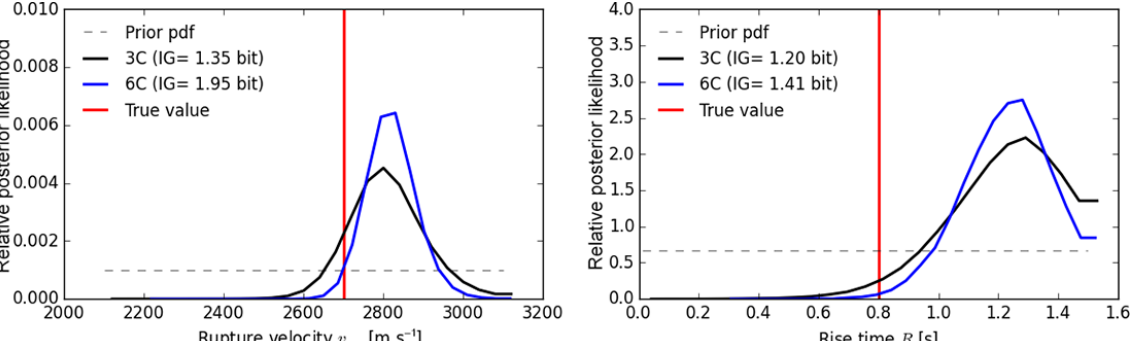
Figure 5. Inversion results for rupture velocity v rup (left) and rise time R (right) for a strike-slip fault. The prior pdf is shown as a black dashed line, the true value as a vertical red line, and the posterior pdf for the 3C inversion as a black line and for the 6C inversion as a blue line. The information gain increased with incorporation of rotation rate data by 45 . 02% for inverting for rupture velocity and by 17 . 77% increase for rise time. The true values are not captured better by the 6C